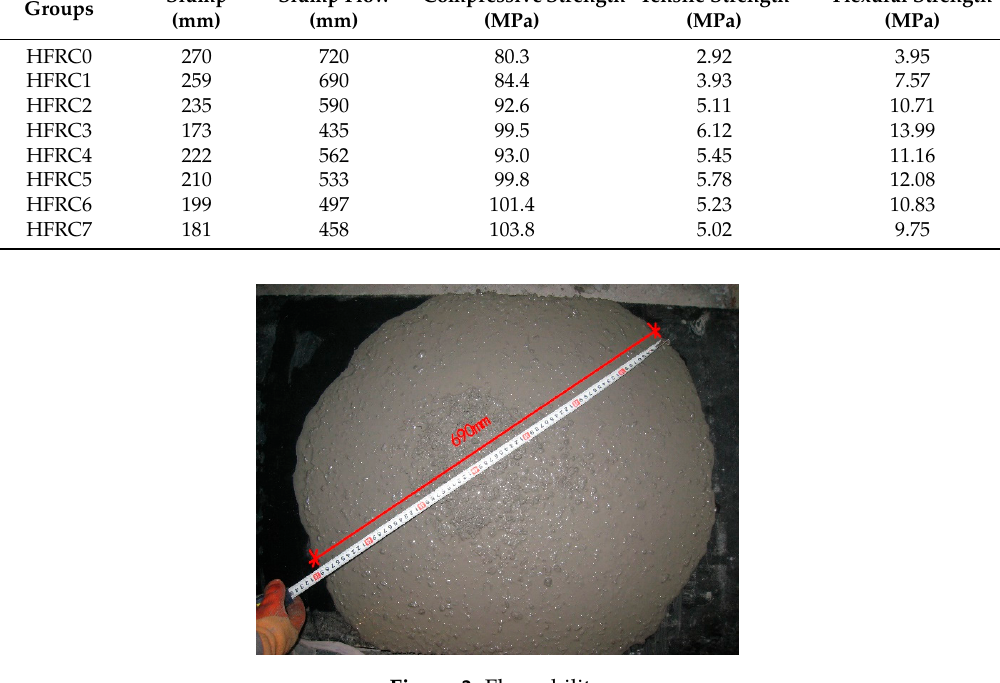
Figure 3. Flow Figure 3. Flow ability.